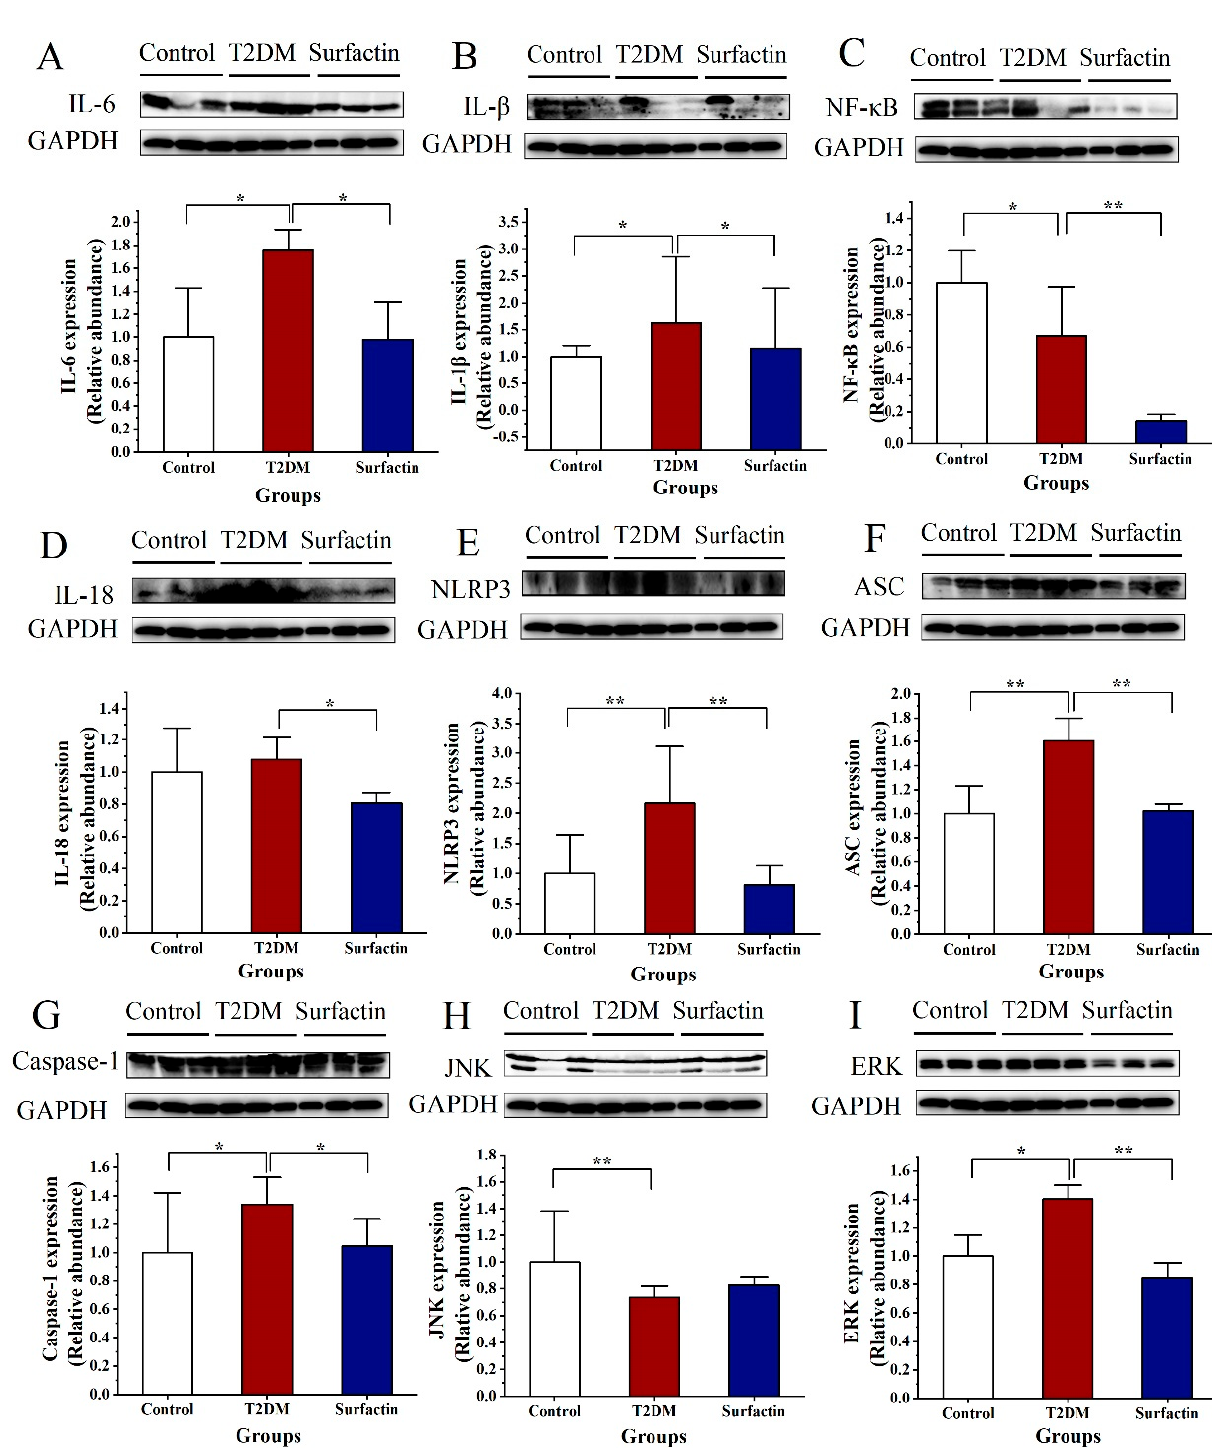
Figure 1. Effects of surfactin on pancreas inflammation in HFD/STZ-induced T2DM mice. The control group represents normal mice fed a basic diet, the T2DM group represents mice with T2DM induced by a 60% fat diet and 30 mg/kg body weight STZ, and the surfactant group represents T2DM mice treated with 80 mg/kg body weight surfactin. The levels of IL-6 ( A ), IL-1 β ( B ), NF- κ B ( C ), IL-18 ( D ), NLRP3 ( E ), ASC ( F ), Caspase-1 ( G ), JNK ( H ) and ERK ( I ). All data are presented as the means ± SD for each group. * indicates significant differences at p < 0.05, ** indicates significant differences at p < 0.01.